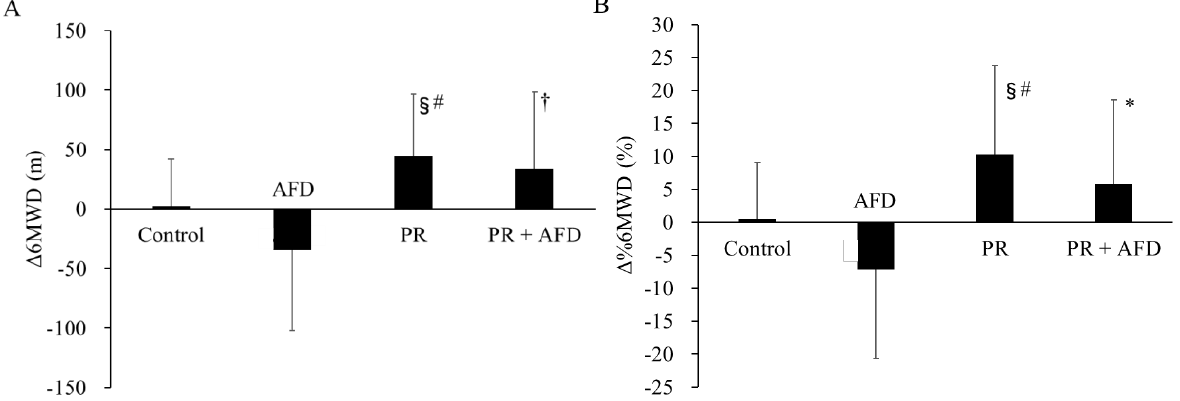
Figure 2. Comparison of the ( A ) change in six-minute walk distance ( ∆ 6MWD) and ( B ) change in the percentage of predicted six-minute walk distance ( ∆ %6MWD) at 3 months between groups. Abbreviations: PR, pulmonary rehabilitation; AFD, antifibrotic drugs; 6MWD, six-minute walk dis- tance; %6MWD, percent predicted six-minute walk distance. Vertical columns indicate means ± SD. p values were calculated using a one-way analysis of variance with post hoc Tukey’s